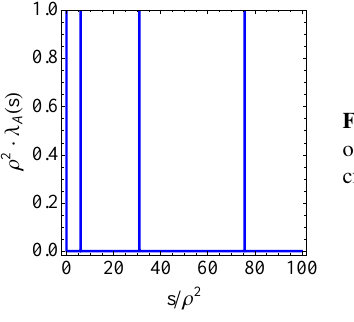
Figure 1. Density of states λ A (normalized by ρ 2 ), as a function of s /ρ 2 , for the KK modes of the gauge bosons in the RS model, cf. Eq. (13). We have used A 1 =